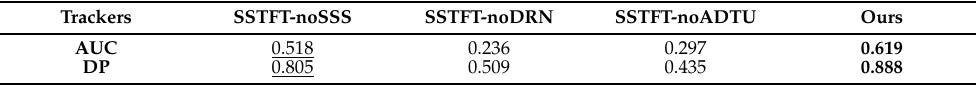
Table 10. Ablation experiment on